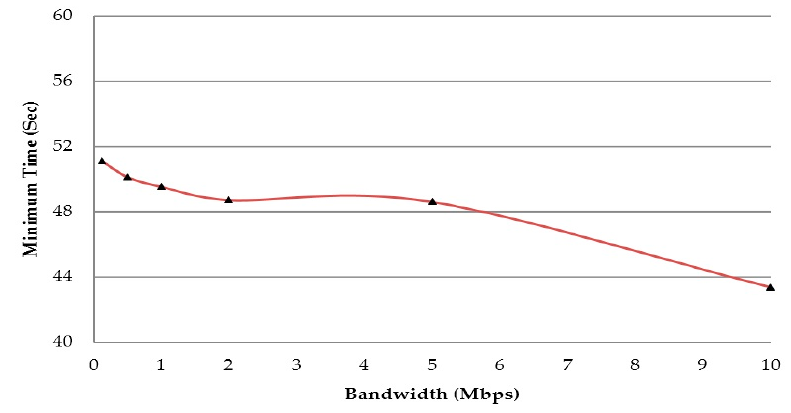
total ). J. Sens. Actuator Netw. 2016 , 5 , 20